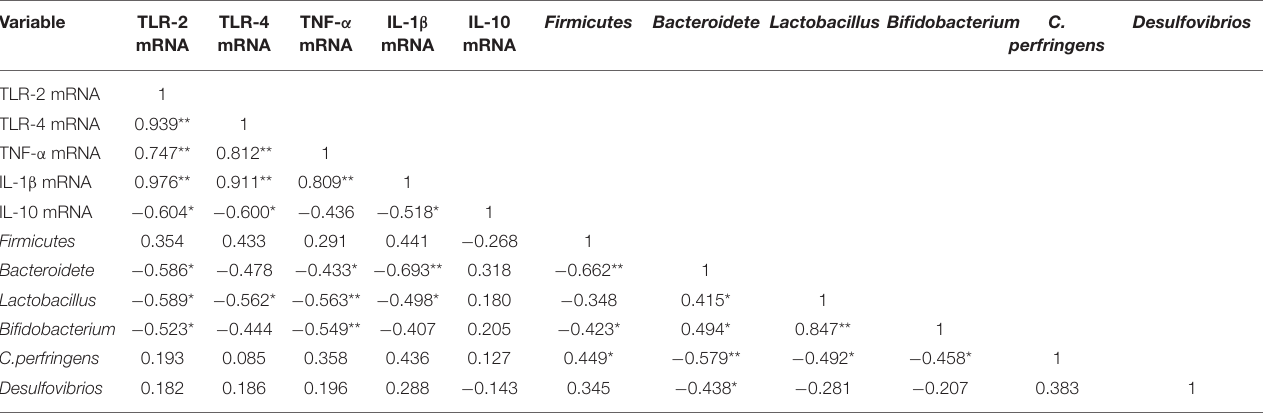
TABLE 6 | Correlation analysis of intestinal inflammation and intestinal microbes.